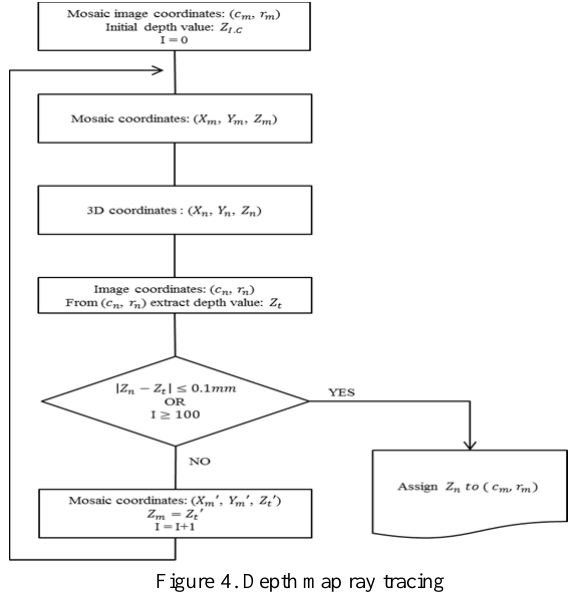
Figure 4. Depth map ray